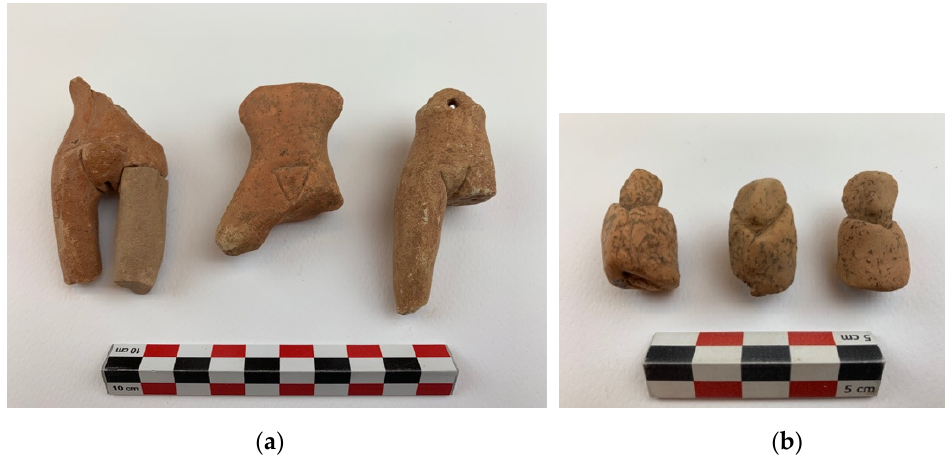
Figure 2. ( a ) Clay lower body models with incised female genitals, one displaying spread legs, and ( b ) clay figurines of swaddled newborns. Petsophas. Crete, c. 2000–1600 BCE. Archaeological Museum of Agios Nikolaos, Crete.